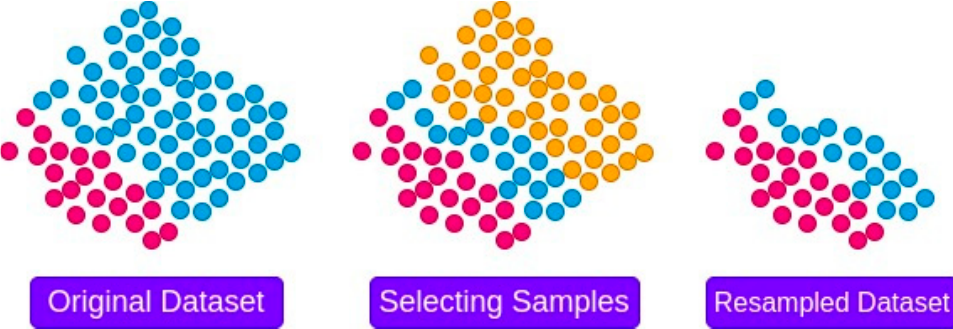
Figure 8. Illustration of NearMiss. This method refers to a collection of undersampling algorithms that select instances based on the distance of majority-class samples to minority-class ones.